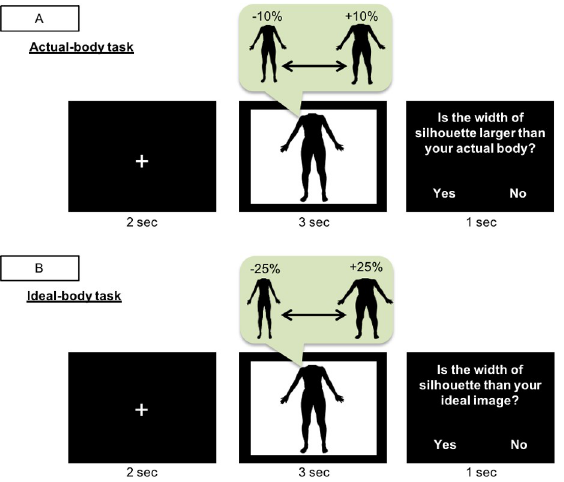
Fig 1. Design of the actual-body and ideal-body tasks. In each trial, participants looked at their own distorted silhouette image for 3 s and then answered a question by pressing the appropriate key. (A) In the actual-body task, participants answered “Yes” if the width of the image exceeded that of their actual body and “No” if it did not. (B) In the ideal-body task, participants answered “Yes” if the width of the image exceeded that of their ideal body and “No” if it did not.